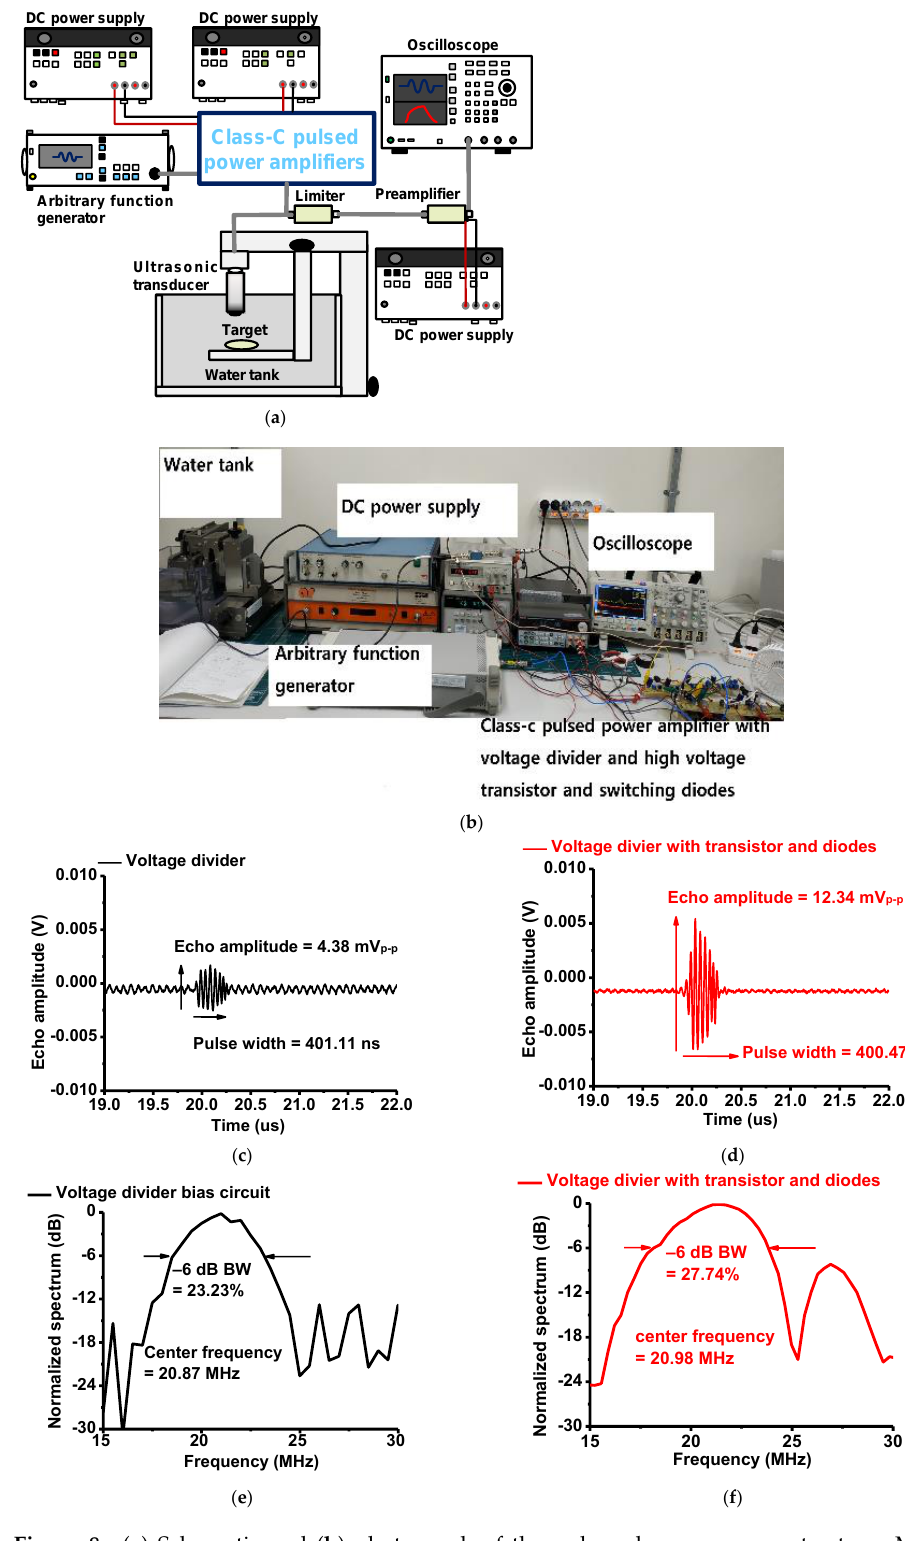
Figure 8. ( a ) Schematic and ( b ) photograph of the pulse-echo measurement setup. Measured echo amplitude of the ultrasonic transducer trigger by the Class-C pulsed power amplifier when using ( c ) an independent voltage divider and ( d ) a voltage divider with high-voltage transistor and switching diode. Measured echo bandwidth of an ultrasonic transducer triggered by a Class-C pulsed power amplifier when using ( e ) an independent voltage divider and ( f ) a voltage divider with a high-voltage transistor and switching diode. The echo amplitude and pulse width were measured as these parameters are related to the sensitivity and axial resolution of the ultrasonic transducer, respectively [38]. The echo amplitude is the peak-to-peak amplitude difference between the highest positive